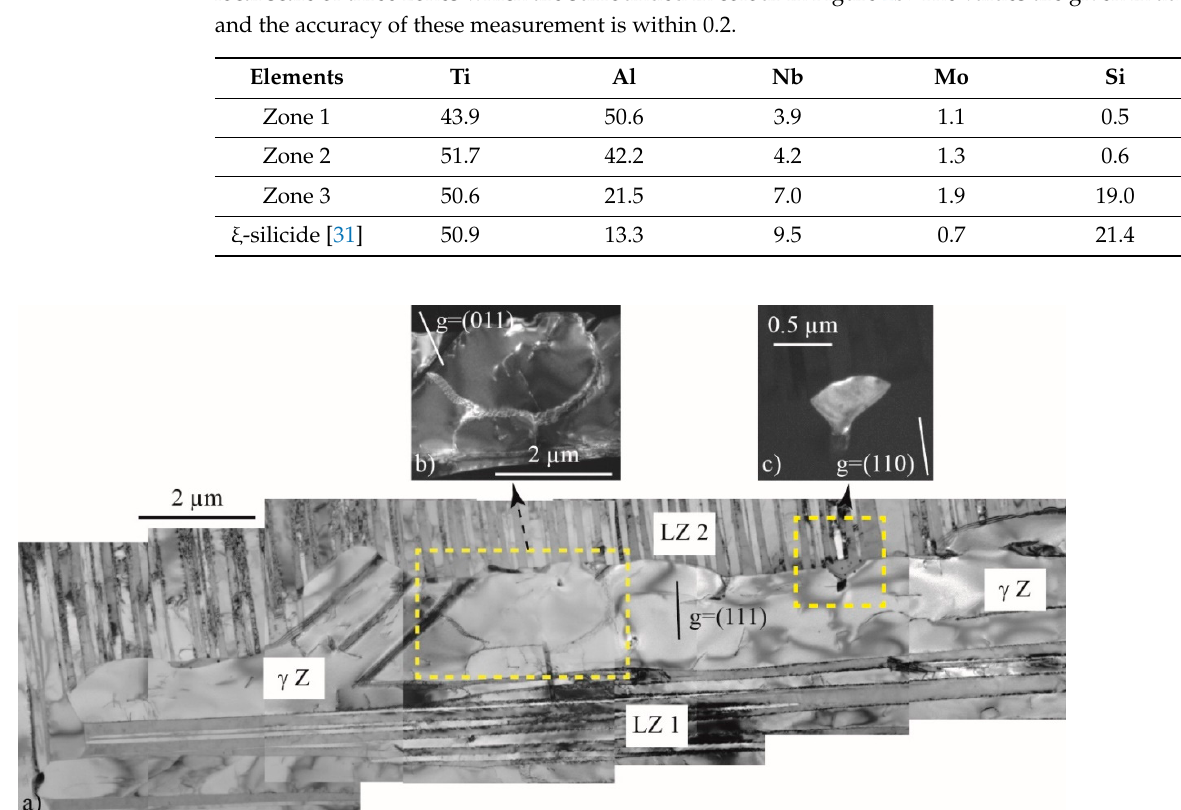
Figure 3. TEM study in TNM + of a γ zone ( γ Z) situated between two lamellar zones labelled LZ1 and LZ2. ( a ) General view in bright field mode; ( b ) ordered domain in dark field mode; and ( c ) β o precipitates in dark field mode.